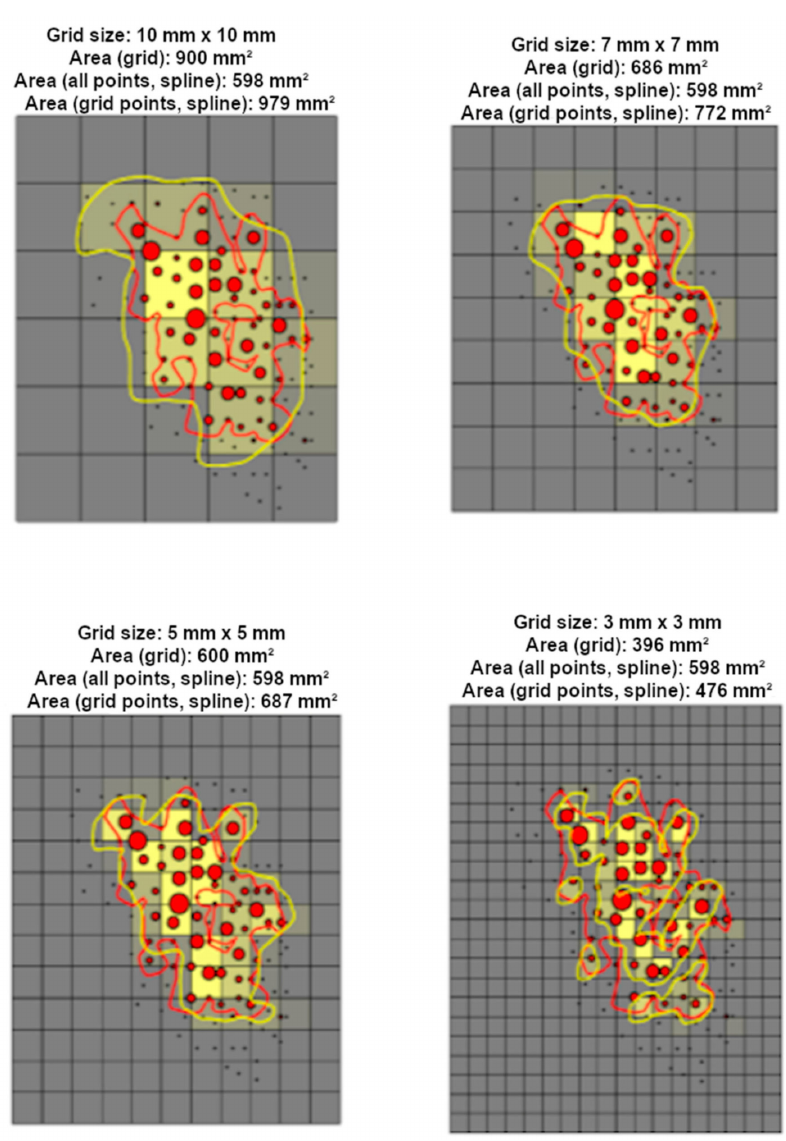
Figure 8. Demonstration of the use of a grid in calculating the area of the motor map. The original individual responses are presented as red-filled dots , with the dot size reflecting the MEP amplitude. The black dots are 0-amplitude responses. Average MEP amplitudes were calculated within grid squares in different size grids. The resulting average MEP amplitude size is reflected in the yellow color of the grid squares. The area of the motor map was evaluated based on the sum of the grid square areas with average MEP amplitudes of at least 50 µ V, and by using spline interpolation ( yellow line ). The corresponding motor map areas are displayed above the grids with the grid sizes. For comparison, the motor map area is displayed for the original responses with spline interpolation, indicated by the red line in each